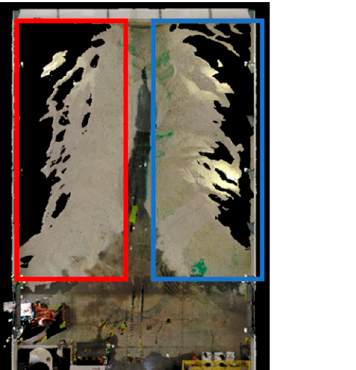
3.2 The comparison between the TLS and SMART volume estimates in Table 6 illustrates two main observations: (1) the relative performance of SMART and TLS given similar oc- clusion pattern (Lebanon dataset); and (2) impact of occlusion extent on the estimated volumes (US-231 dataset). For the Lebanon dataset, where the SMART and TLS had com- parable occlusion percentage, one can see that they both produce similar volumes. This is an indication of the SMART’s ability to deliver volume estimates that are as precise as those derived from TLS. For the US-231 dataset, on the other hand, the difference percent- age is in the range of 3%, which is a direct result of higher occlusion percentage for the SMART system. Salt Repositioning Test: In the Lebanon facility, a salt repositioning test was per- formed to further examine the volumetric accuracy attained by the proposed system. Ini- tially, the stockpile consisted of two large heaps on the left and right sides of the facility. Using a bucket loader, two small quantities of salt were picked and moved into two new piles (Figure 29). The shapes of the original and repositioned salt piles are shown in Figure 30. Following the repositioning, another set of scans were captured by the SMART and TLS units.